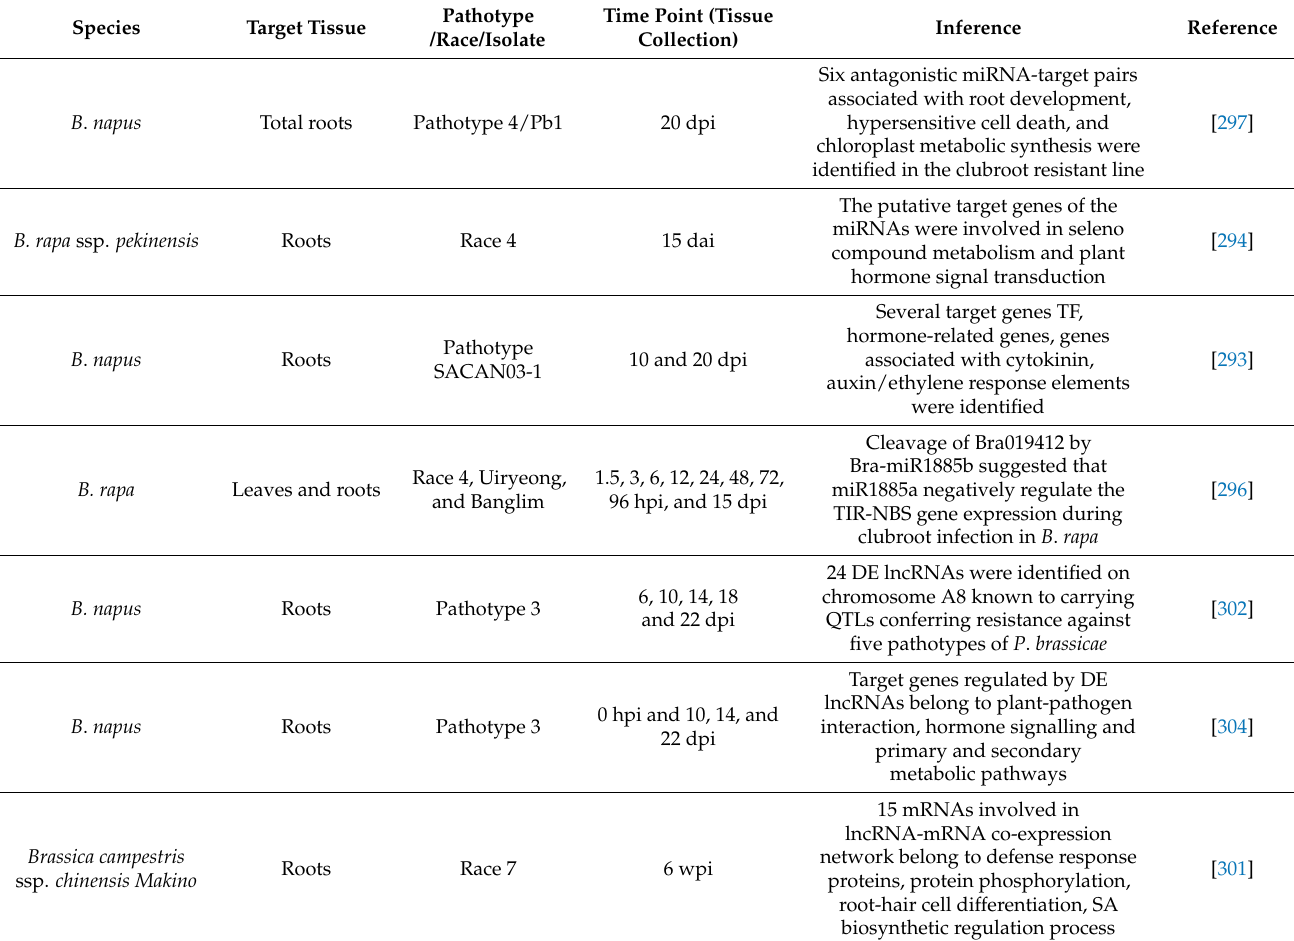
Table 4. Published ncRNA studies in Brassica spp. on clubroot